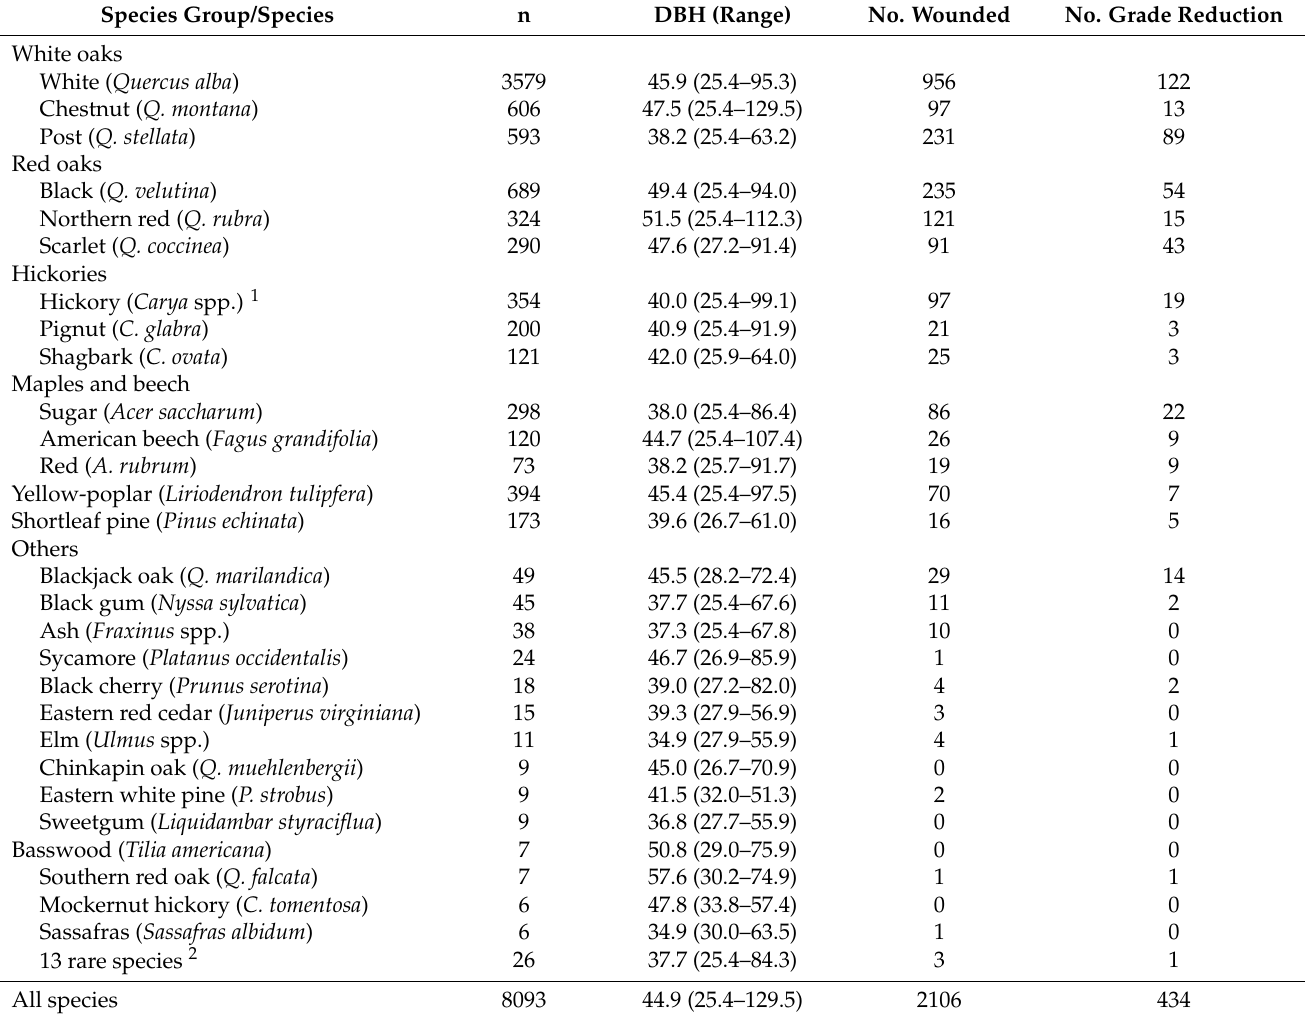
Table 1. Number of trees measured, average and range of diameters at breast height (DBH; cm), number of trees wounded and number of trees with a fire-related reduction in U.S. Forest Service tree grade [40] by species groups and species. The “Other” group contains miscellaneous and rare species that had less than 50 individuals measured. Latin names are given in